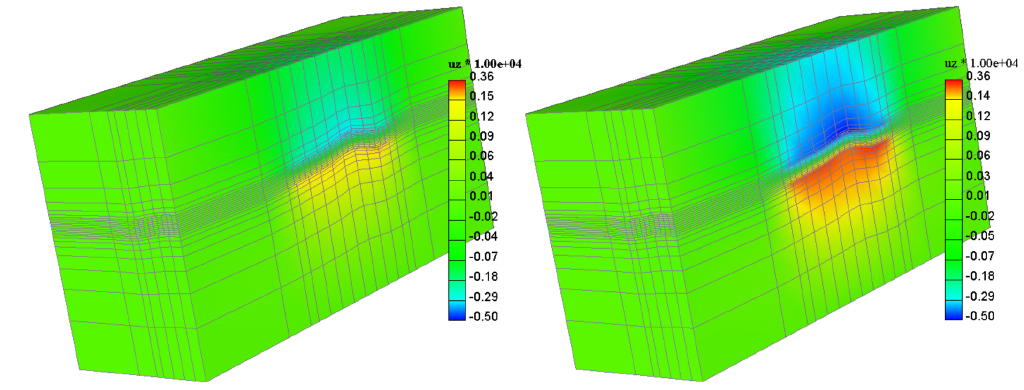
Figure 32. u z snapshots at 20 and 40 years of evolution for